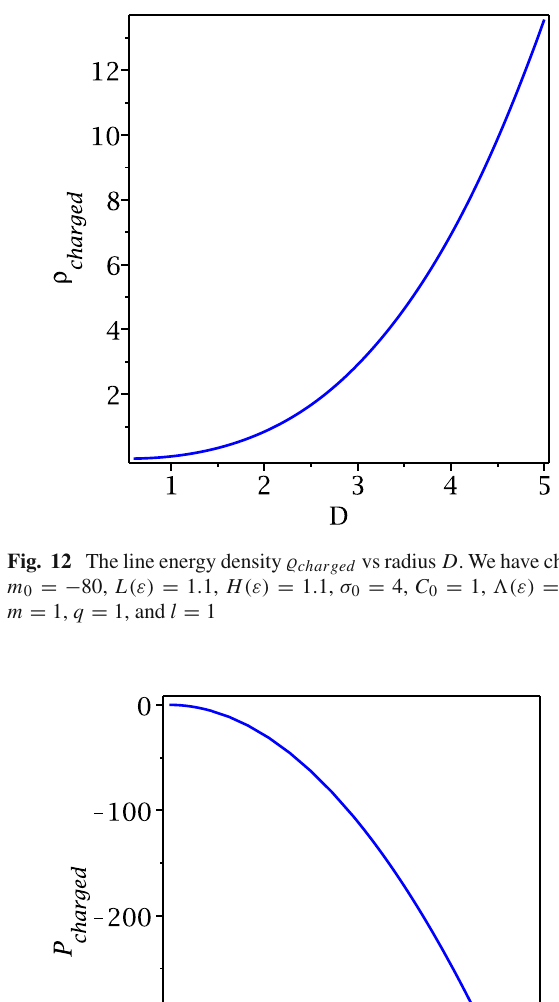
= 4, C = 1, (cid:8)(ε) = − 1, m = 1, 0 0